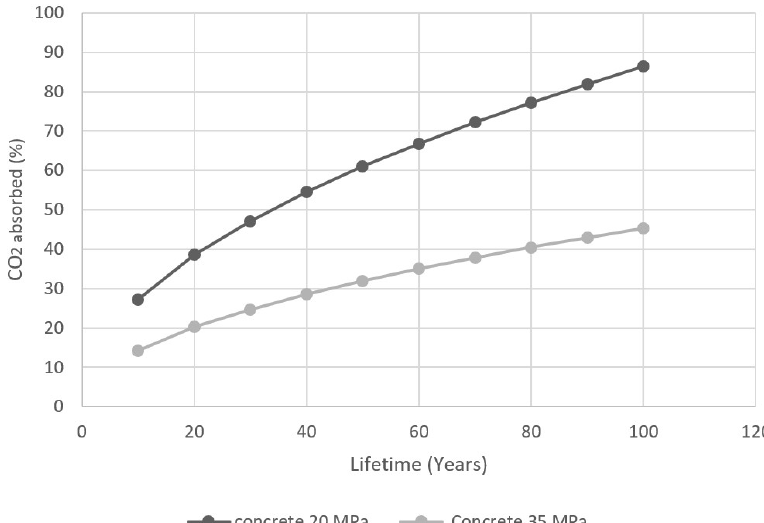
Figure 12. Comparison of the carbonation of the beam with a span of 6.50 m for a useful life ranging from 10 to 100